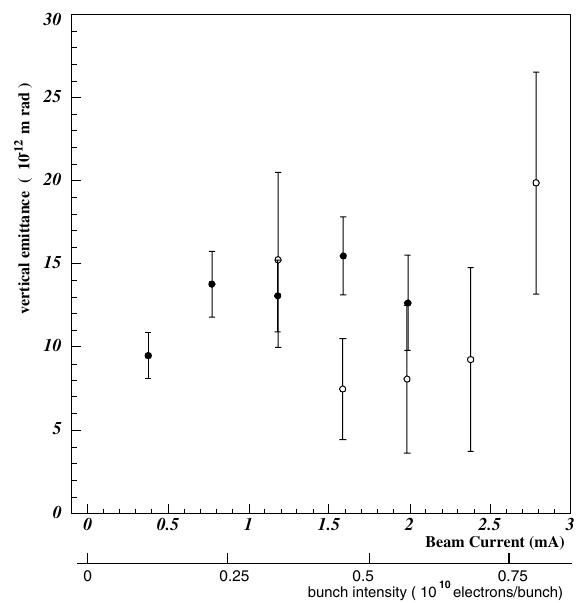
FIG. 14. Vertical emittance in the single-bunch mode (from Ref. [1]).